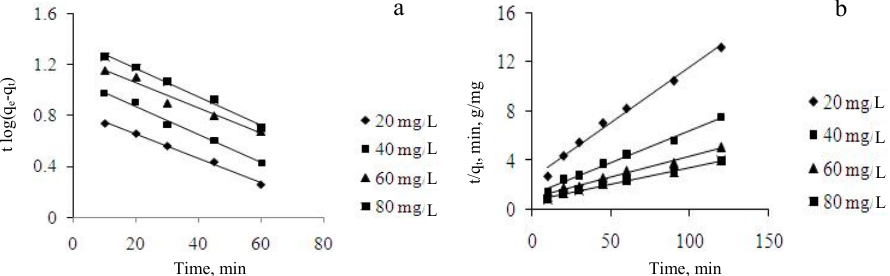
Figure 5. Kinetic plots for the adsorption of MG onto CSAC, (a) Pseudo- first order plot, (b) Pseudo- second order